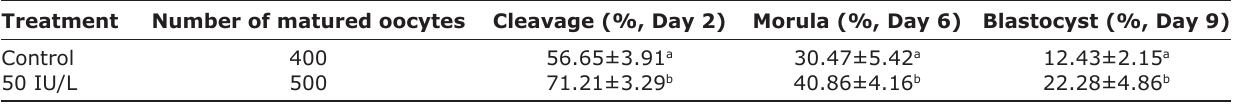
Table-2: Embryonic developmental stages of oocytes submitted to different FSH supplementation on Bligon goat oocyte following in vitro culture.